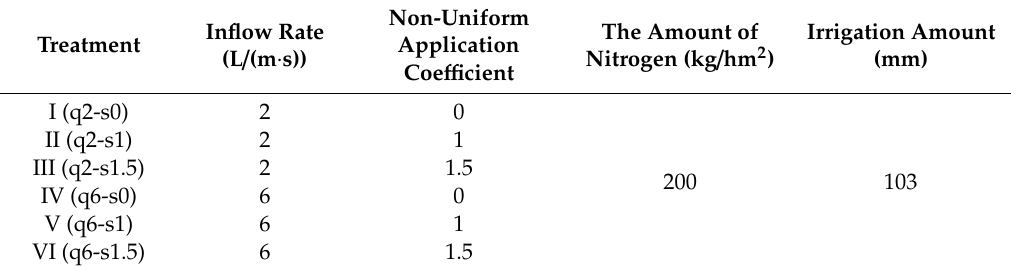
Table 2. Experimental